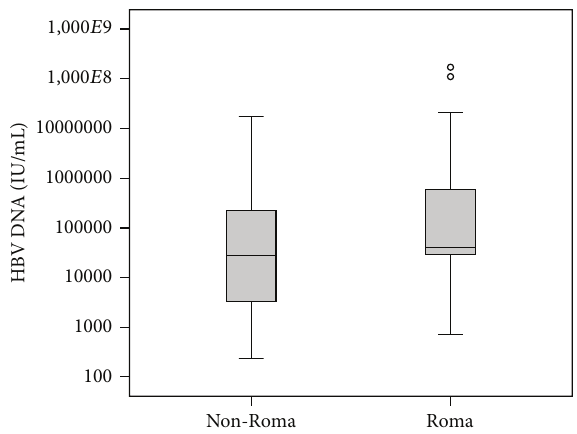
Figure 1: HBV DNA before treatment in Roma and majority (non- Roma)